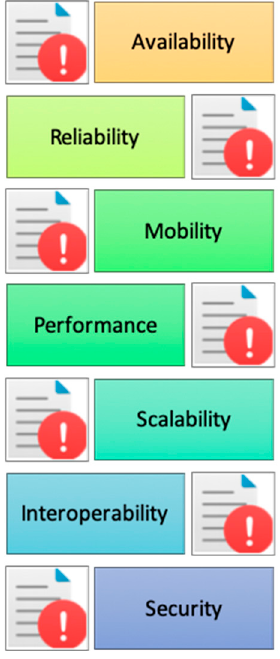
Figure 5. Healthcare systems’ open issues. Electronics 2019 , 8 , x FOR PEER REVIEW